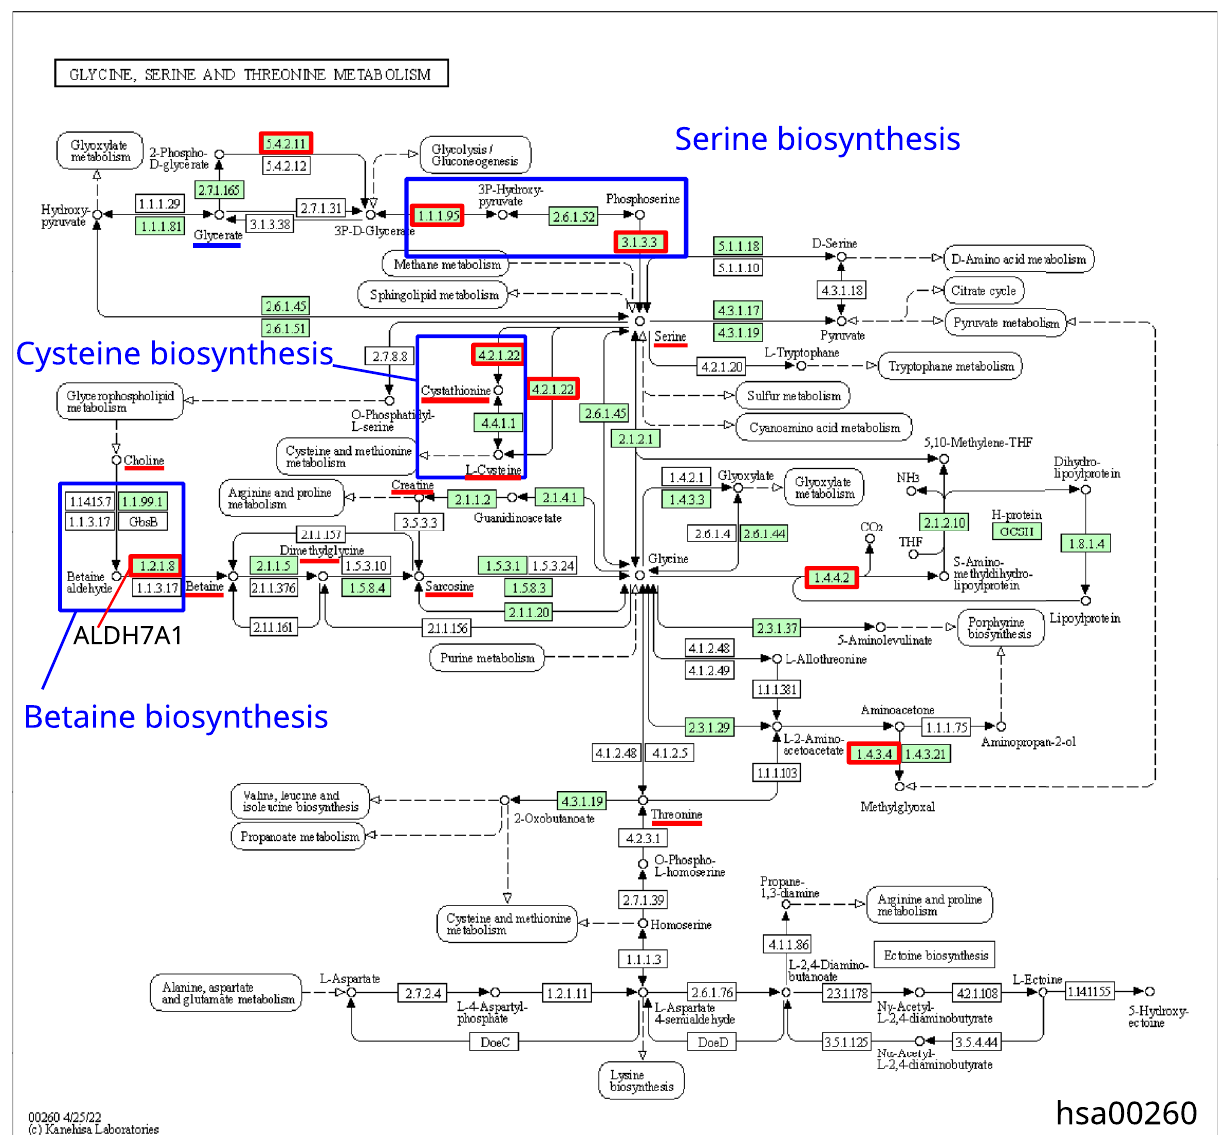
www. kegg. jp/ pathw ay/ hsa00 260). Enzymes that can be the potential targets of viral proteins are shown by red boxes, metabolites increased in the plasma of COVID-19 patients are underscored by red line, while those decreased are underscored by blue